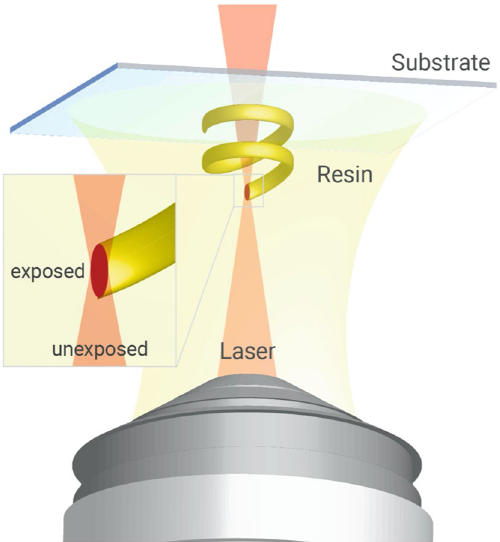
Figure. 7. Schematic diagram illustrating the principles of operation of a nano-3D-printer. Reprinted with permission from Nanoscribe GmbH (https ://www.nanos cribe